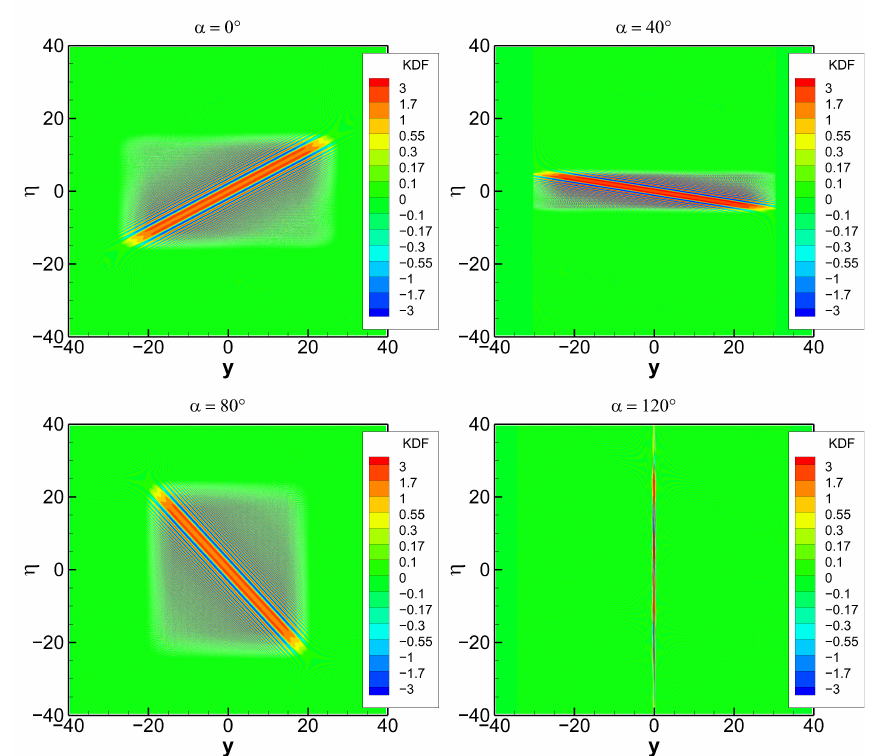
Figure 2. KDF ρ K α of function ˜ ψ α ( y ) in rotated coordinates ( y , η ) . The rotation angle α takes the values of 0 ◦ , 40 ◦ , 80 ◦ , and 120 ◦ .